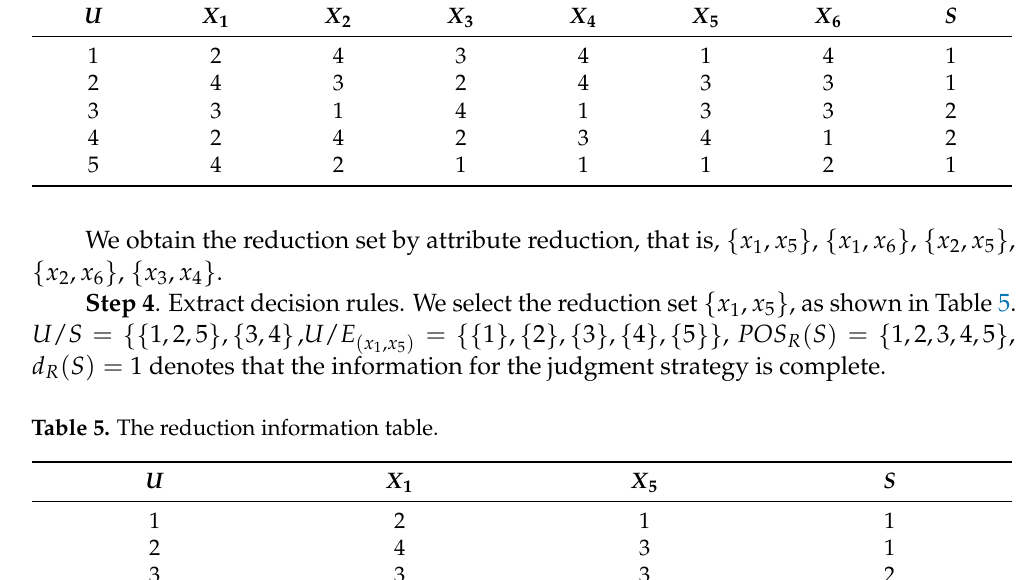
Table 4. The reduction information table of enterprise B 2 . U